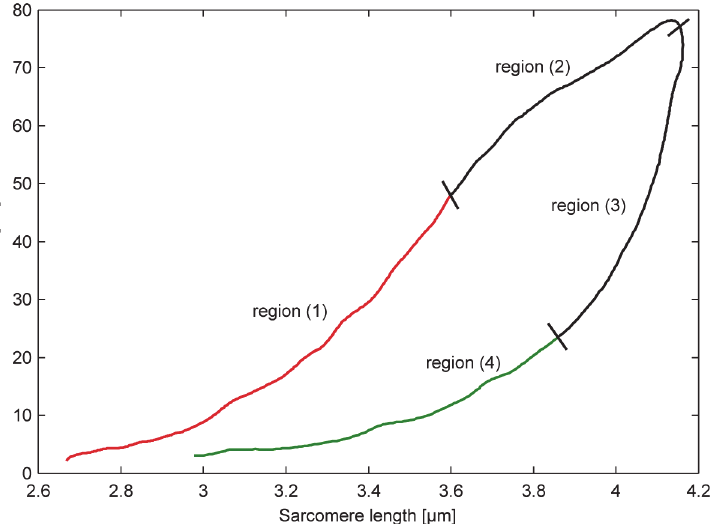
Fig 2. Force versus average sarcomere length of a myofibril first stretched in a low-calcium solution and then shortened again. The red line corresponds to region (1) where no unfolding of IG domains took place; the green line to region (4) where no further folding-unfolding of IG domains took place.